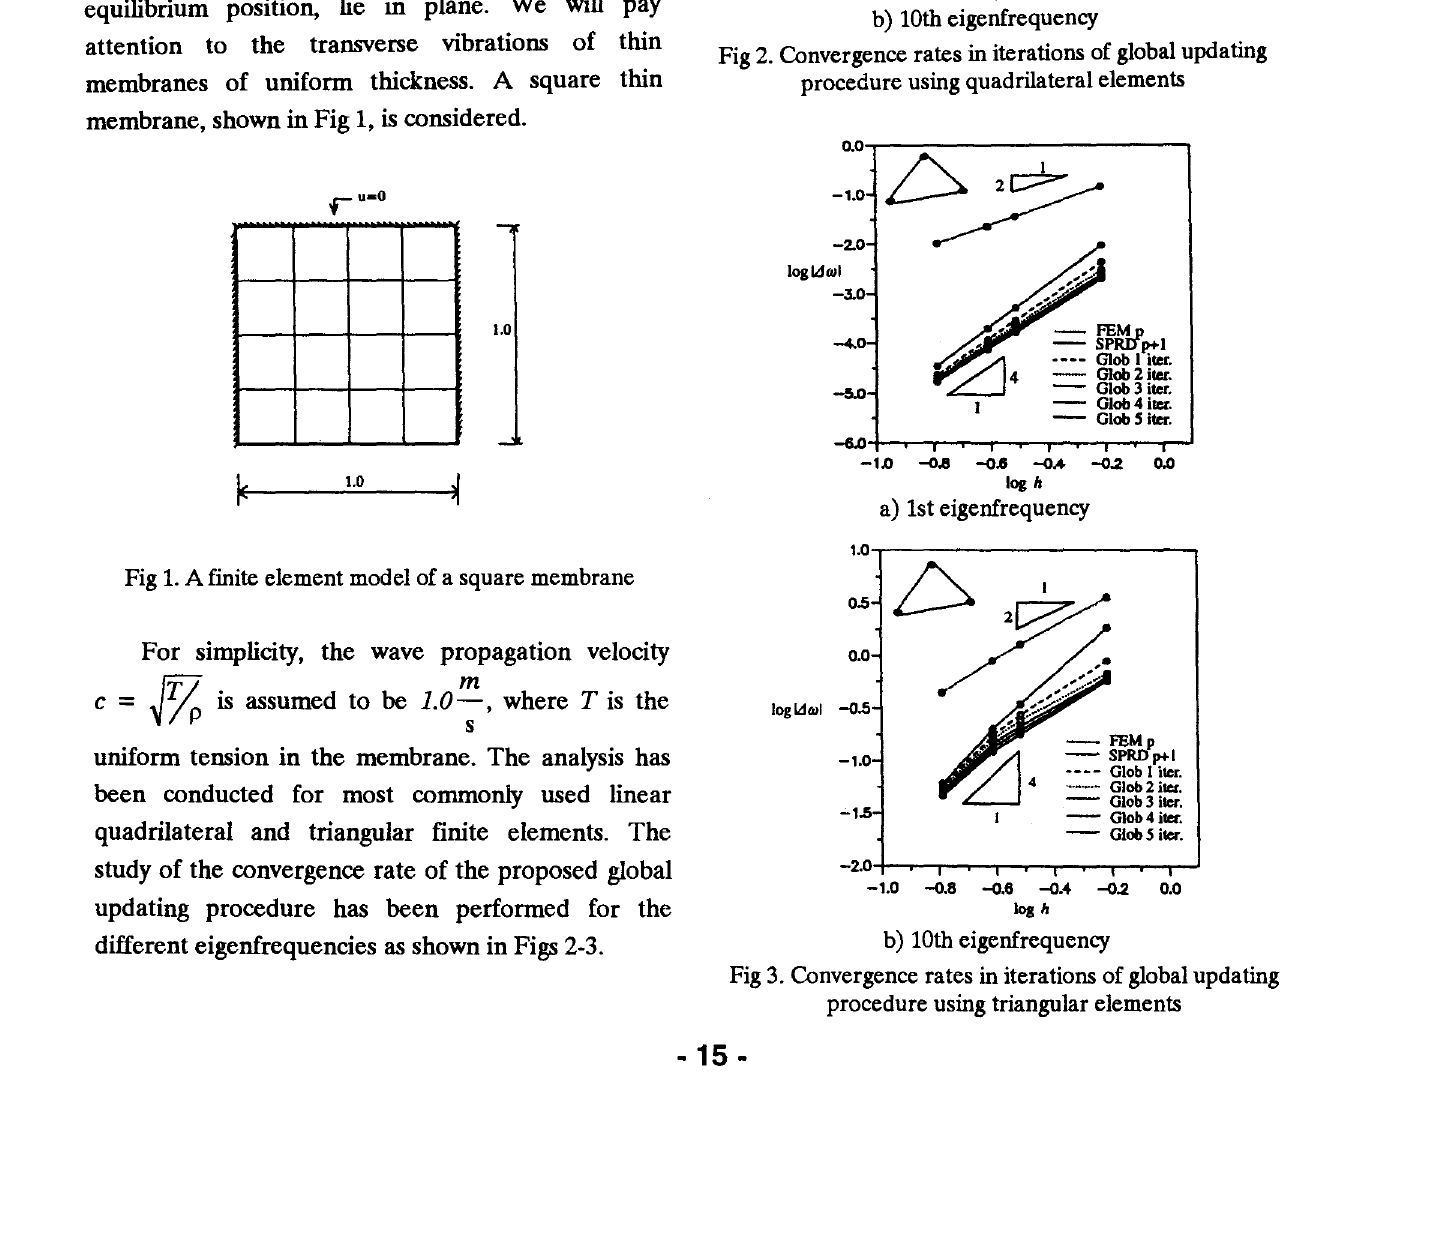
Fig 2. Convergence rates in iterations of global updating procedure using quadrilateral elements